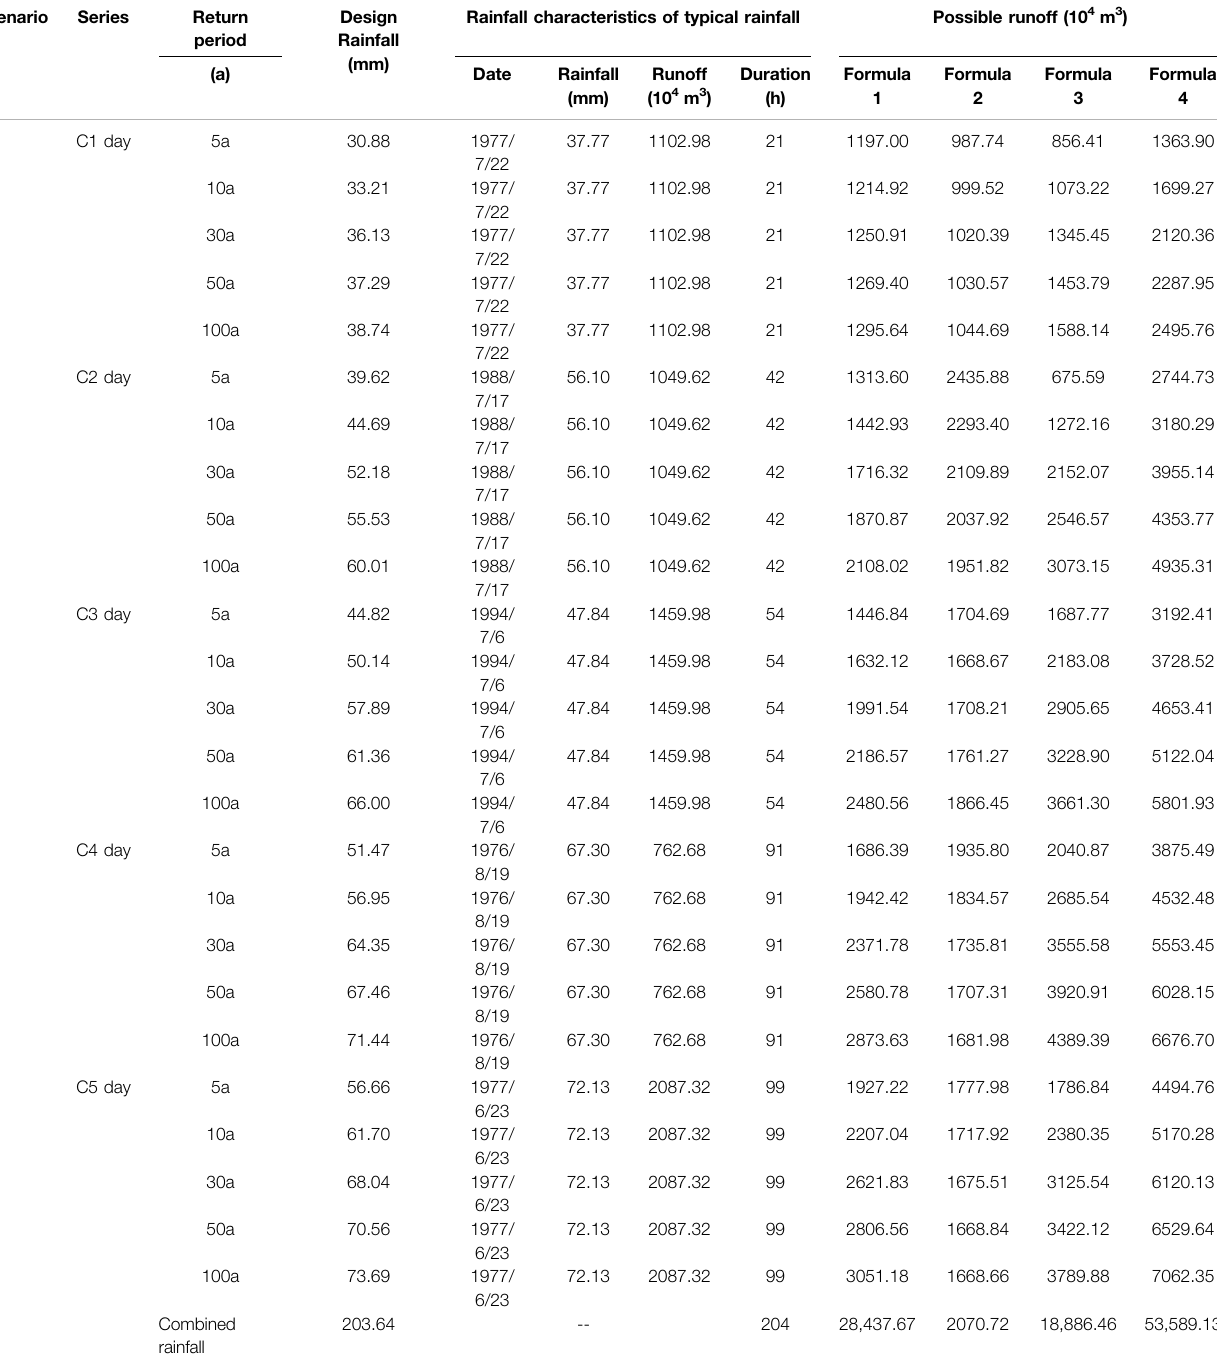
TABLE 5 | Possible incoming fl ood amount under two extreme rainfall